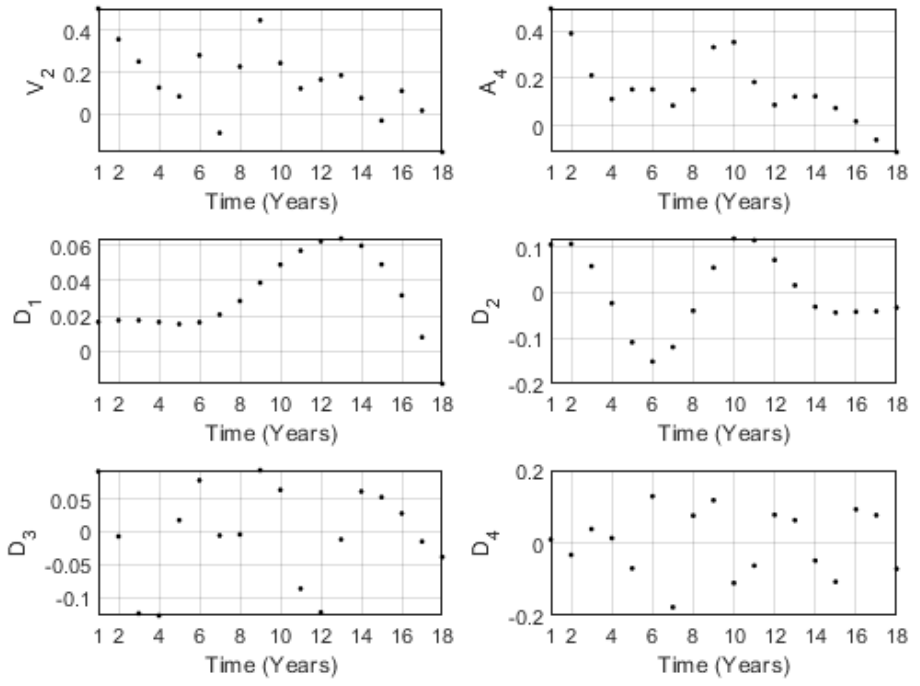
Figure 2. The wavelet decomposition of the variable V 2 at the level 4.